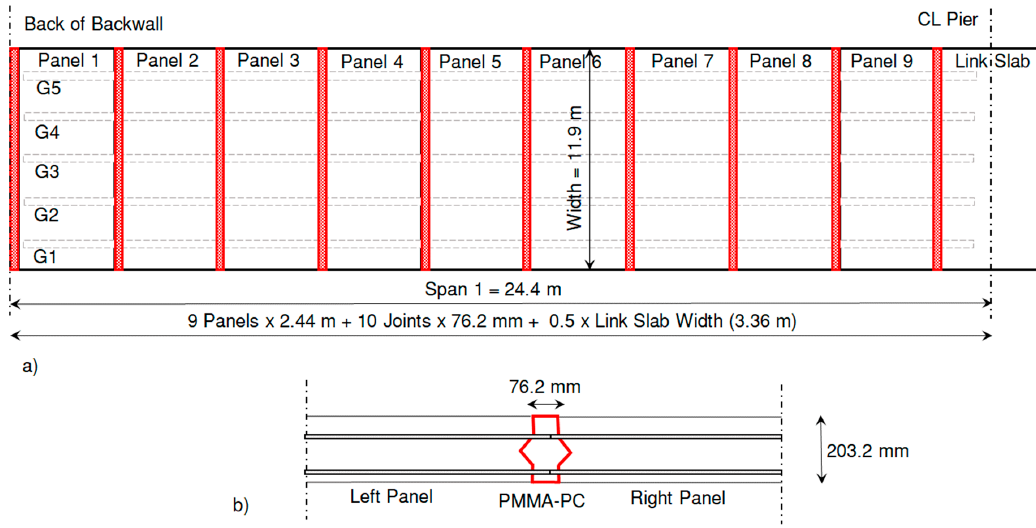
Figure 13. Bridge example with precast deck panel using PMMA-PC joints: ( a ) panel layout; ( b ) joint size. Table 4. Design Comparison Between UHPC and PMMA-PC Closure Joints.